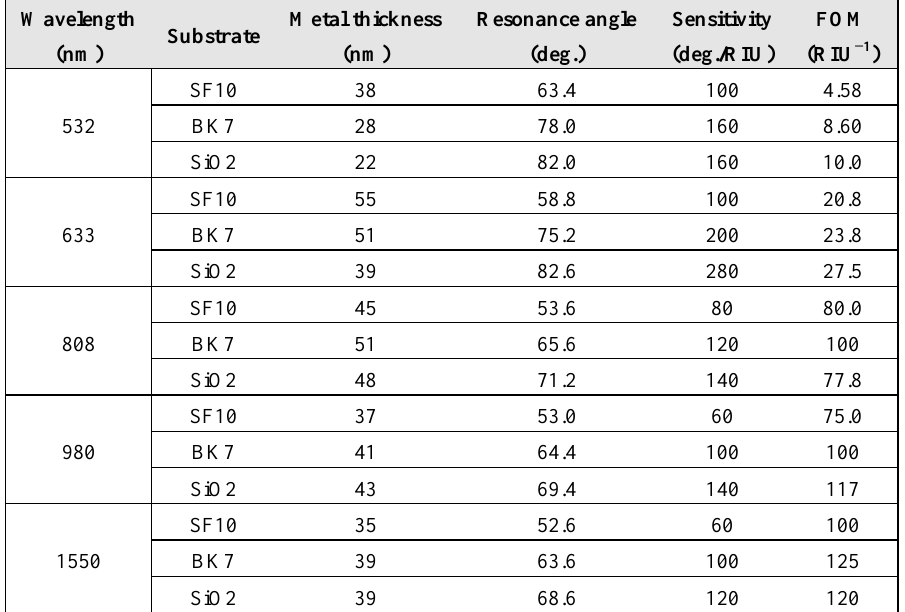
Table B. Optimal characteristics of a Kretschmann configuration-based sensor with an Au